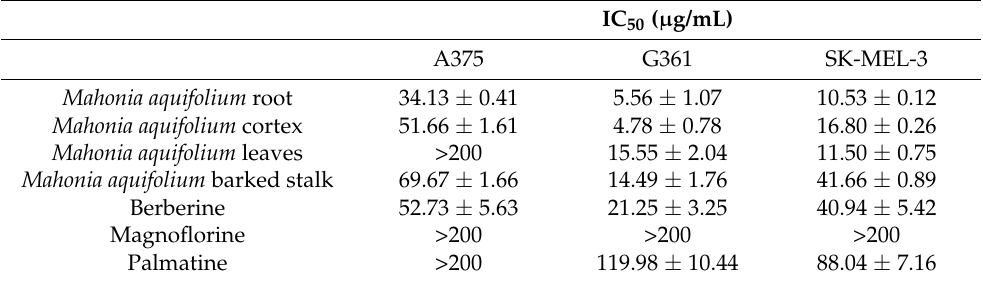
Table 3. Cytotoxic activity, expressed as IC 50 values, of the investigated extracts and alkaloid standards against three melanoma cell lines (A375, G361,